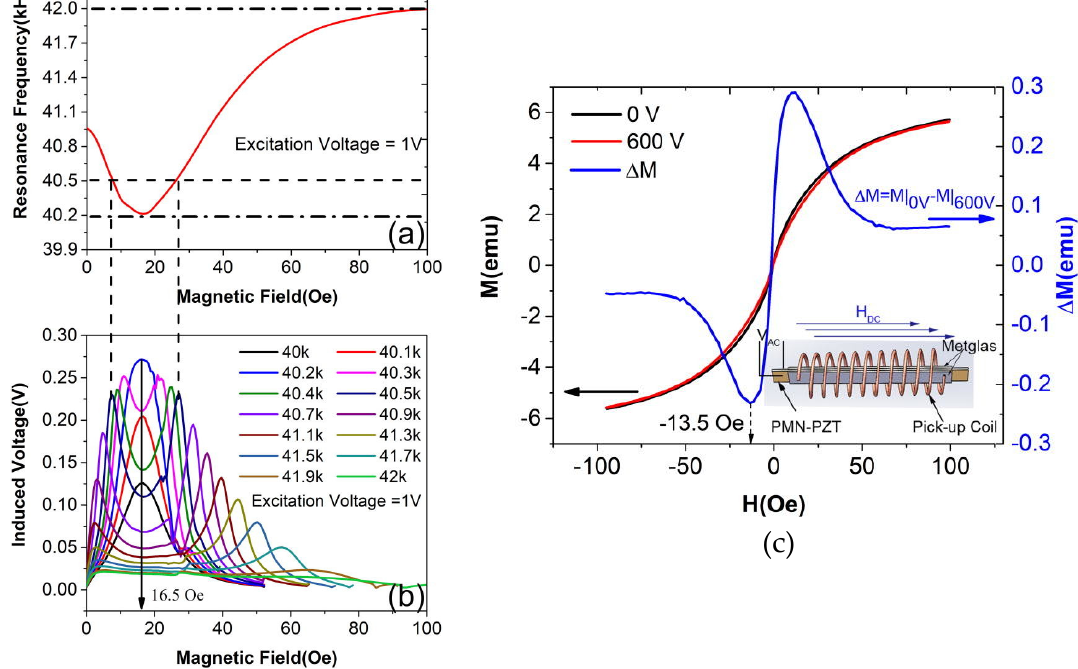
Figure 16. ( a ) The resonance frequency of the ME laminate as a function of applied H DC , ( b ) The induced voltage as a function of applied HDC and excitation frequency, ( c ) The M-H loop of the ME laminate with voltages of 0 V and 600 V applied to the piezoelectric crystal. ΔM as a function of external HDC is also given on the right. The inset shows the schematic of the ME heterostructure. Reproduced with permission from [104] .